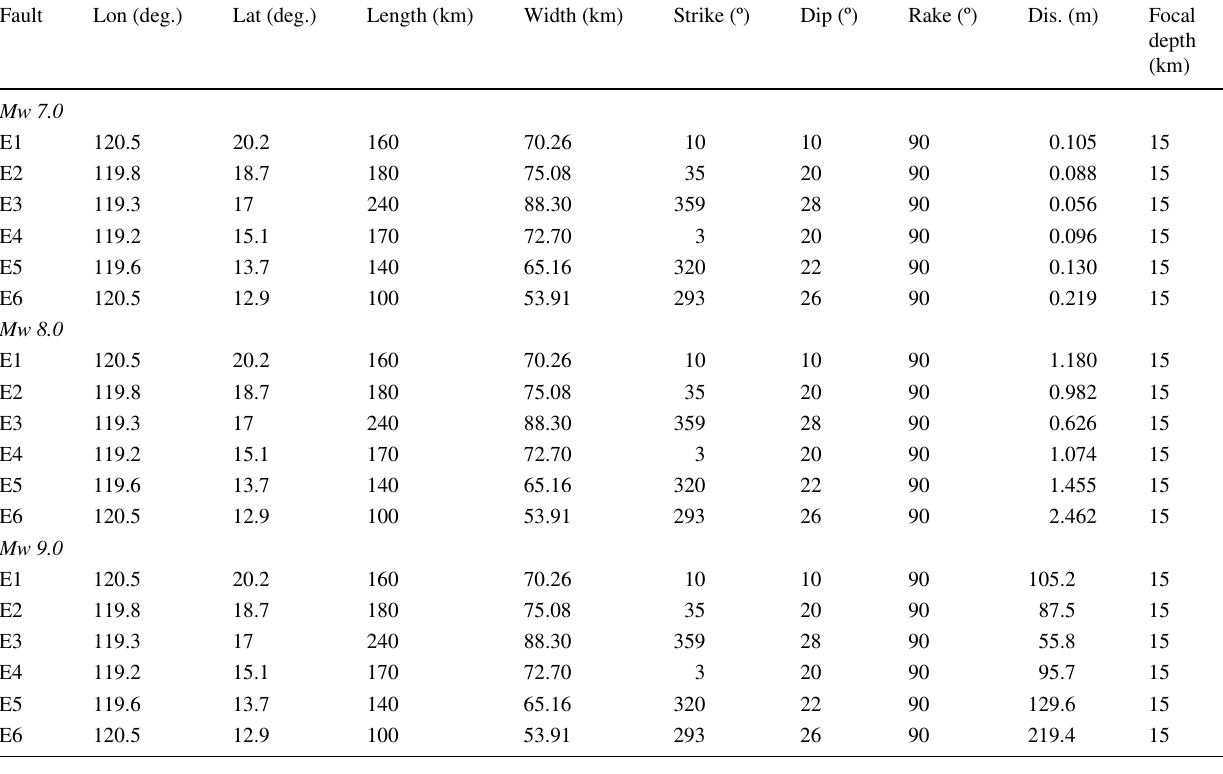
Table 1 Manila Trench earthquake fault parameters